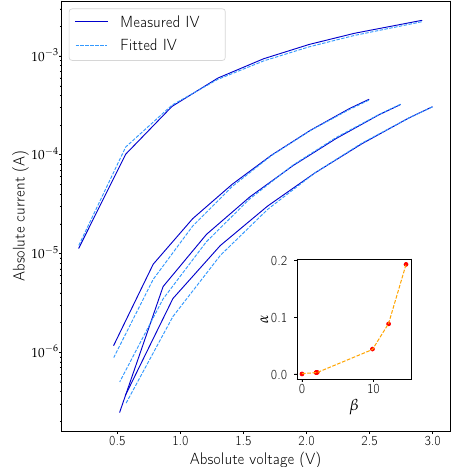
Figure 3. Fitting of data extracted from a 4µm 2 IGZO memristor to the empirical Equation (10a). The fitting data are used to model the static I-V characteristic of the device. The inset graph represents the α − β relation, two fitting variables related exponentially by Equation (10b). The filled dots in the inset graph represent the best-fitting α and β variables for each I-V curve, and the dashed line is the result of applying the second exponential fitting defined by Equation (10b). The second fitting is fundamental to prevent having two independent state variables influencing the dynamics of the